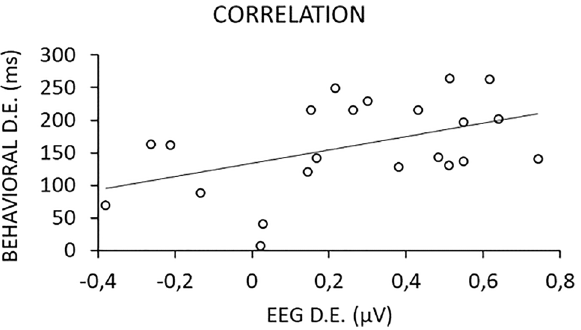
Figure 4. Significant correlation between the behavioral and brain distance effect (D.E.) for each participant except the